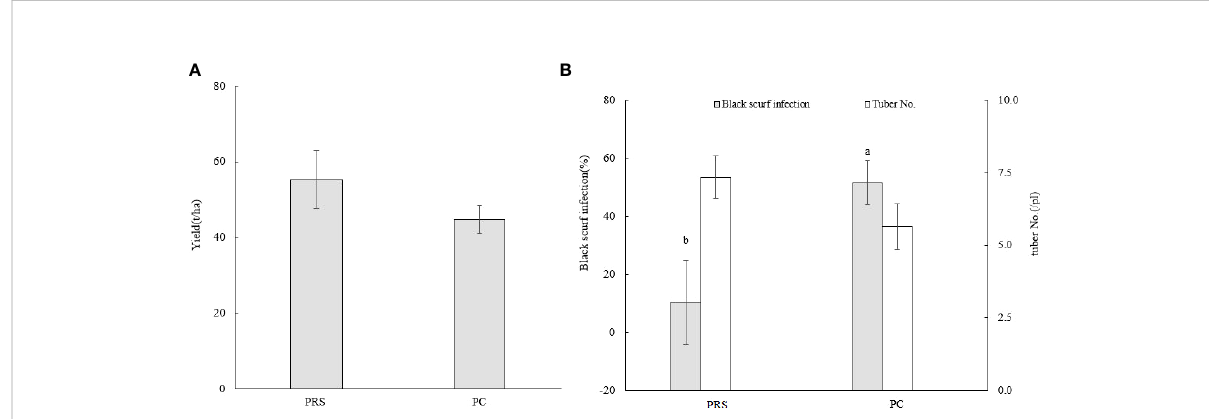
FIGURE 1 Potato yield (A) and black scurf infection of tubers (B) . PRS indicate the mean yield of potato from O treatment in 2020 and PR treatment in 2021. The grey bar indicates tuber black scurf infection and the white bar indicates tuber No. in (B) . Different lowercase letters at the top of the bar indicate signi fi cant differences at P < 0.05